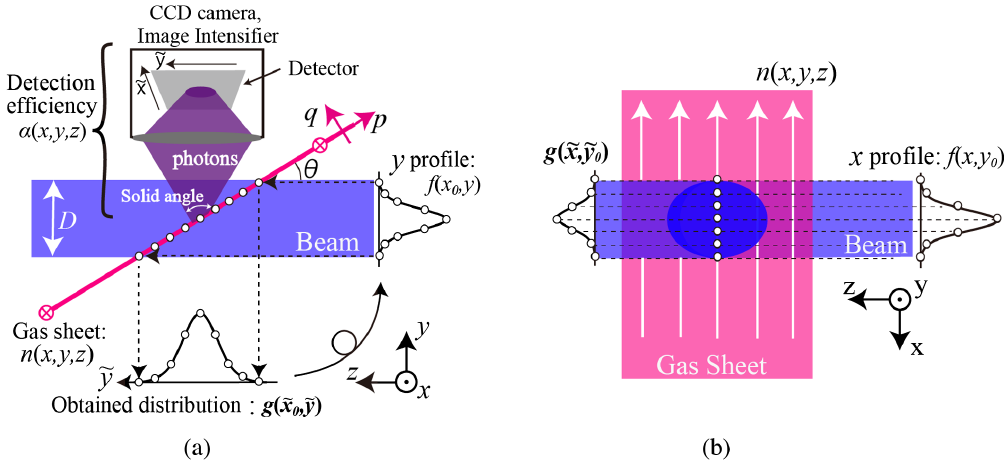
FIG. 2. The geometry of the gas sheet monitor and the beam: (a) the side view and (b) the top view. The camera captures the top view image of the photon distribution, g ð ˜ x; ˜ y Þ , produced by beam-gas interaction. The transverse beam intensity distribution, the gas density distribution, and the detection efficiency distribution are described as f ð x; y Þ , n ð x; y; z Þ , and α ð x; y; z Þ , respectively. The typical beam size along y axis is described as D